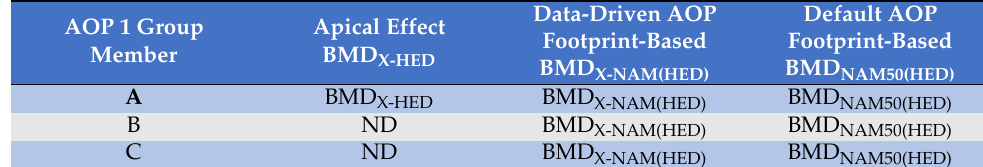
Table 1. Suggested array of Benchmark Doses (BMDs) to calculate for chemical mixture members within an AOP grouping. For a given AOP proposed to be involved in the elicitation of a specific adverse outcome, the human equivalent dose apical effect BMD(s) and NAM-based human equivalent dose BMDs should be calculated for all members of an AOP footprint grouping, where and when data are available. It is recommended to calculate BMDs based on both data-driven/expert-determined benchmark responses (BMR) appropriate for the type of data/effect, and a default such as a BMR 50 as a comparison. ND = not